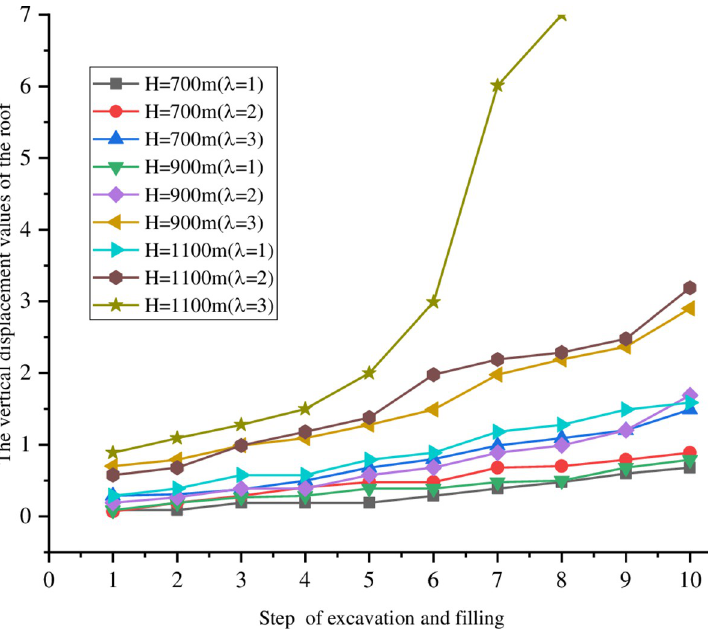
Fig 8. Vertical displacement of monitoring points on the bottom at different